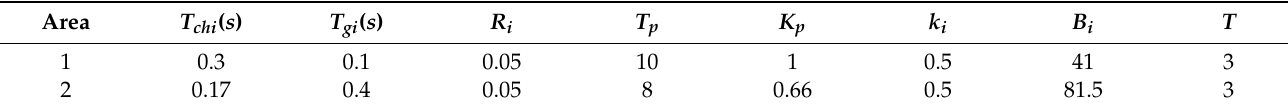
Table 1. Nominal values of model parameters.